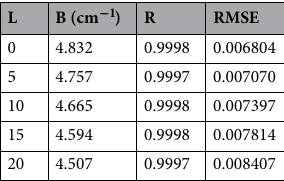
Table 3. Results of numerical fit to function T ′